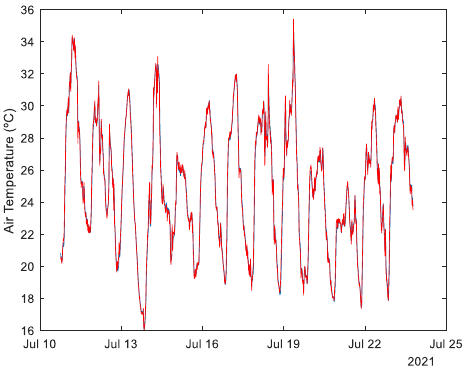
Figure 17. Measured (blue) and one-step-ahead predicted (red) air temperature.